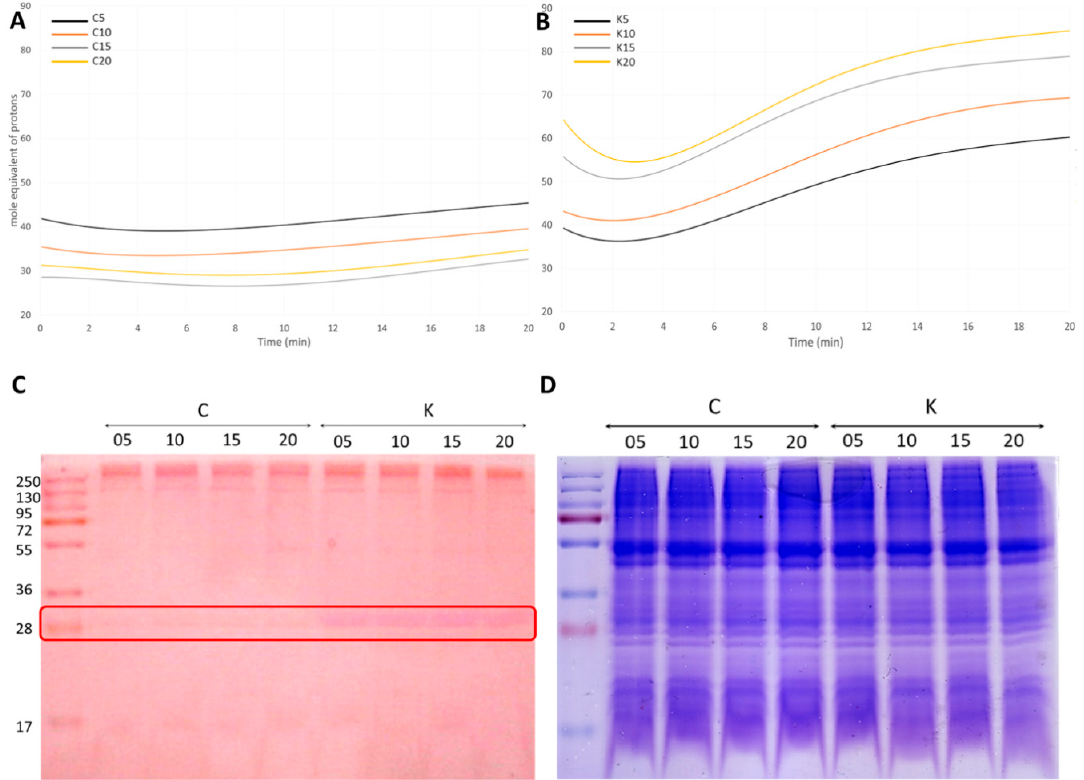
Figure 4. Zoospore carbonic anhydrase (CA) enzymatic activity assay. Whole cell extracts were prepared at each time point (5, 10, 15, 20 min) without (C for control) or with a K + gradient application (K). Upper panels ( A ) and ( B ) show CA enzymatic kinetics at different time points posttreatment, for controls or K + -treated cells. The amount of product formed is plotted as a function of time along the CA assay. Lower panels ( C , D ) show protonography analysis of CA enzymatic activity performed using neutral red as indicator of proton amount and Blue Coomassie staining as positive control for revelation of total protein patterns, respectively.